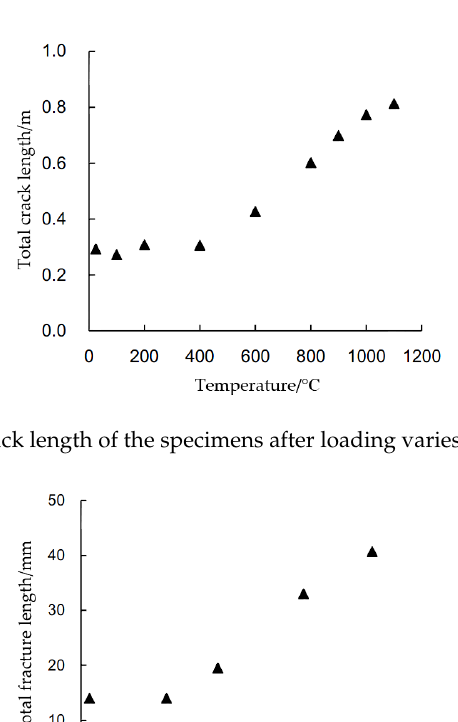
Figure 14. Experimental results of ultimate failure mode of the granite specimens after the heating treatment [25]: ( a ) T = 100 ◦ C; ( b ) T = 200 ◦ C; ( c ) T = 400 ◦ C; ( d ) T = 600 ◦ C; ( e ) T = 800 ◦ C; ( f ) T = 900 ◦ C; ( g ) T = 1000 ◦ C; and ( h ) T = 1100 ◦ C.